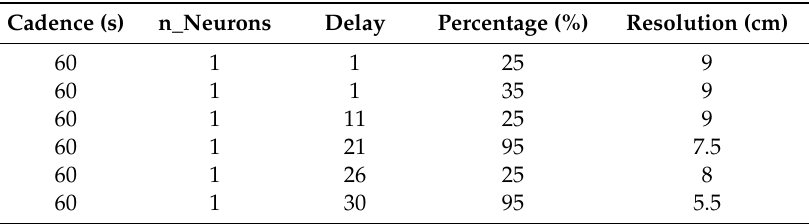
Table 8. Simulations for 60 s